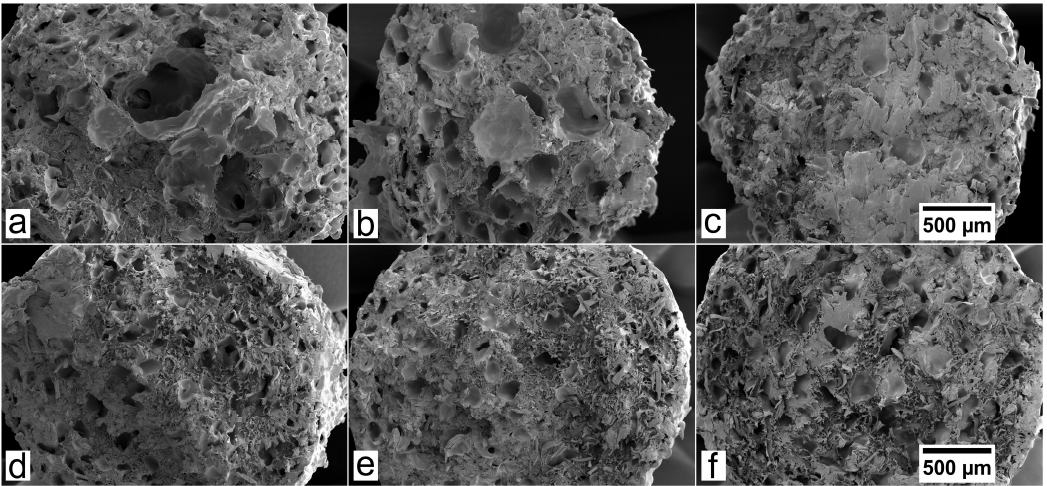
Figure 7. SEM images of the biocomposite filaments. BioPE1 containing 20% of untreated TMP fibers ( a ); 20% LG-treated TMP fibers ( b ); and 20% OG-treated TMP fibers ( c ). BioPE2 containing 20% of untreated TMP fibers ( d ); 20% LG-treated TMP fibers ( e ); and 20% OG-treated TMP fibers ( f ). All the images were acquired at 50× magnification in SEI mode. Table 2. Measurement of the % of void fraction in the manufactured filaments.